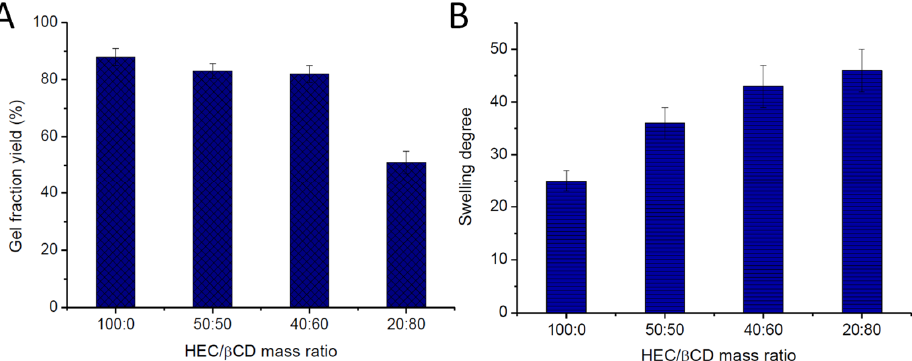
Figure 3. Effect of HEC/β-CDAc 3 mass ratio on the gel fraction yield (A) and swelling degree of cryogels (B).